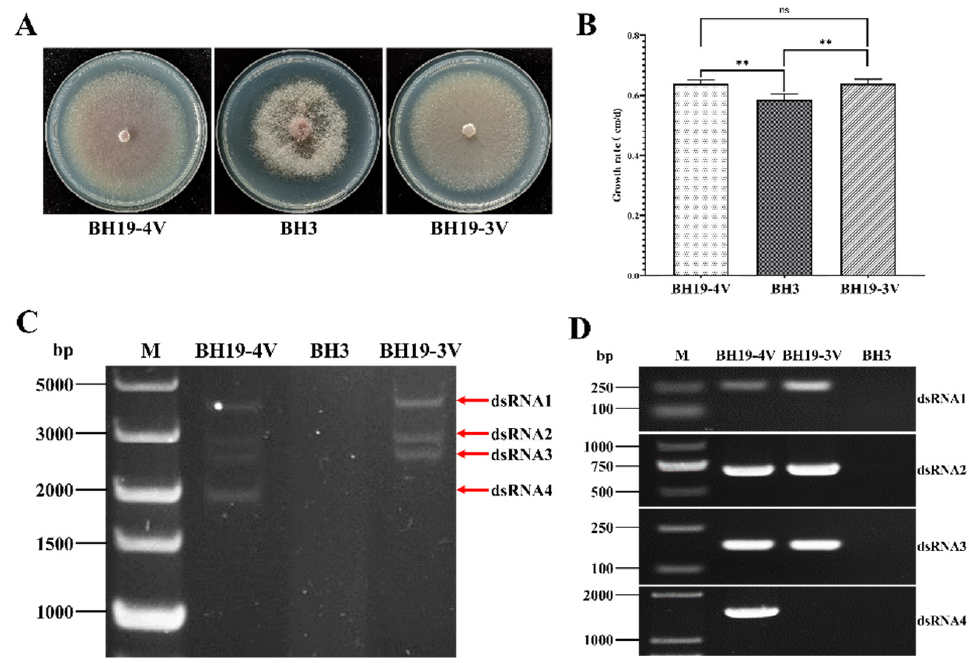
Figure 6. ( A ) Colony morphology of F oxysporum strains BH3, BH19-3V and BH19-4V. ( B ) The